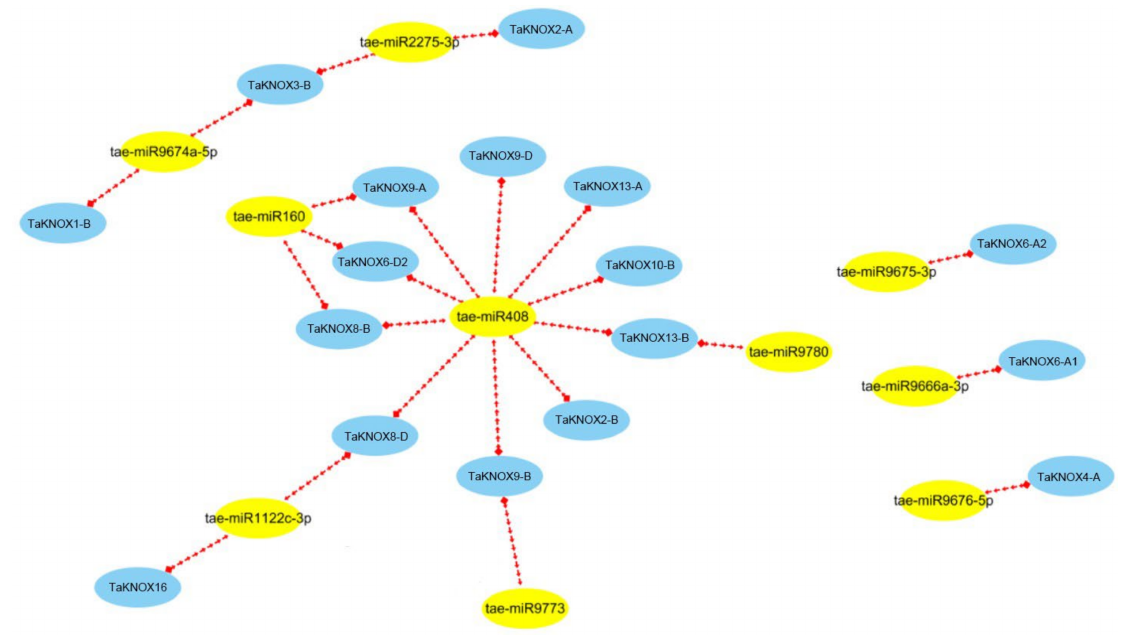
Figure 4. The co-expression regulatory network of TaKNOX cascade genes in wheat. Box color: blue, TaKNOX gene in wheat; yellow: miRNAs targeted by KNOX genes in